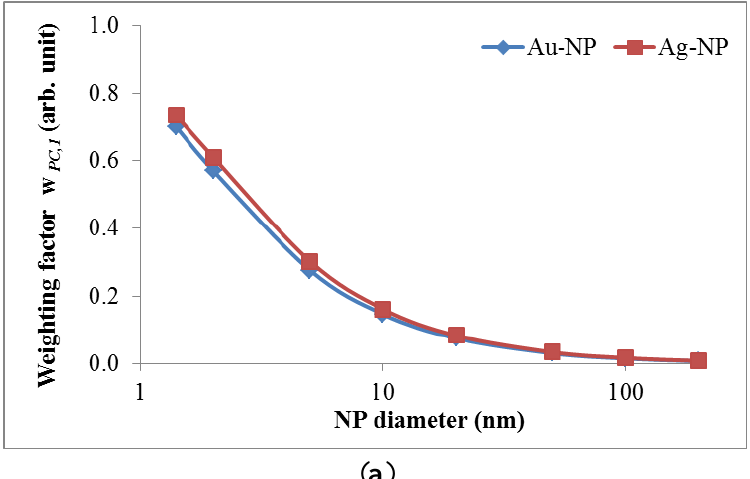
Figure 1. Weighting factor 1 in arbitrary units which is proportional to SSA— i.e. , the ratio of atoms/molecules at the NP surface over the total number of atoms/molecules: ( a ) gold (Au) and silver (Ag) NP, ( b ) TiO 2 , CuO, Fe 2 O 3 , and Fe 3 O 4 , ( c ) for agglomerated NPs with 2, 5 and 10 nm primary particle size, ( d ) spherical and agglomerated TiO 2 with different primary sizes. Panels (c) and (d) show that w PC , 1 is constant for different sizes of agglomerates but changes with the SSA of primary